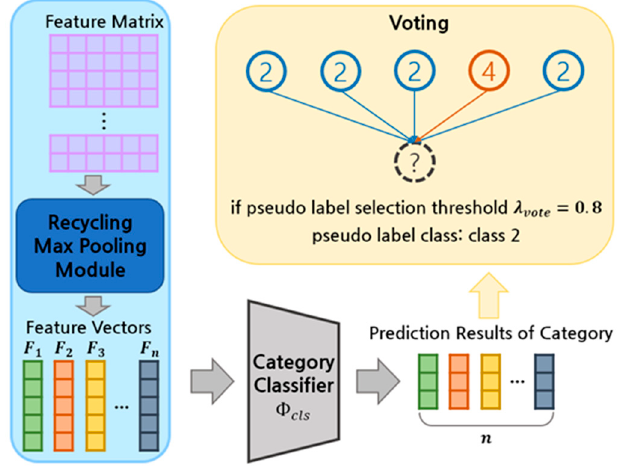
Figure 3. Pseudo-label voting process utilizing recycling max pooling module.